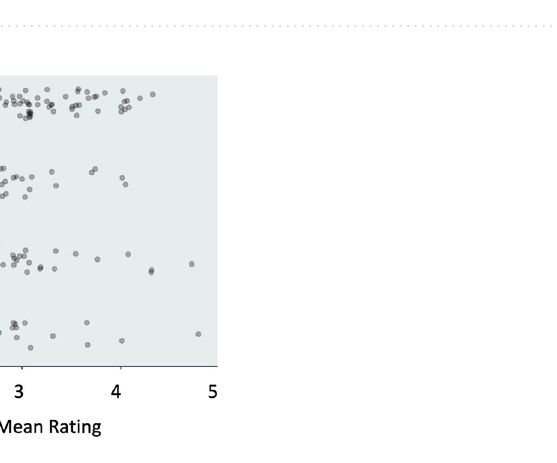
Figure 4. PHQ-4 ratings split by schedule